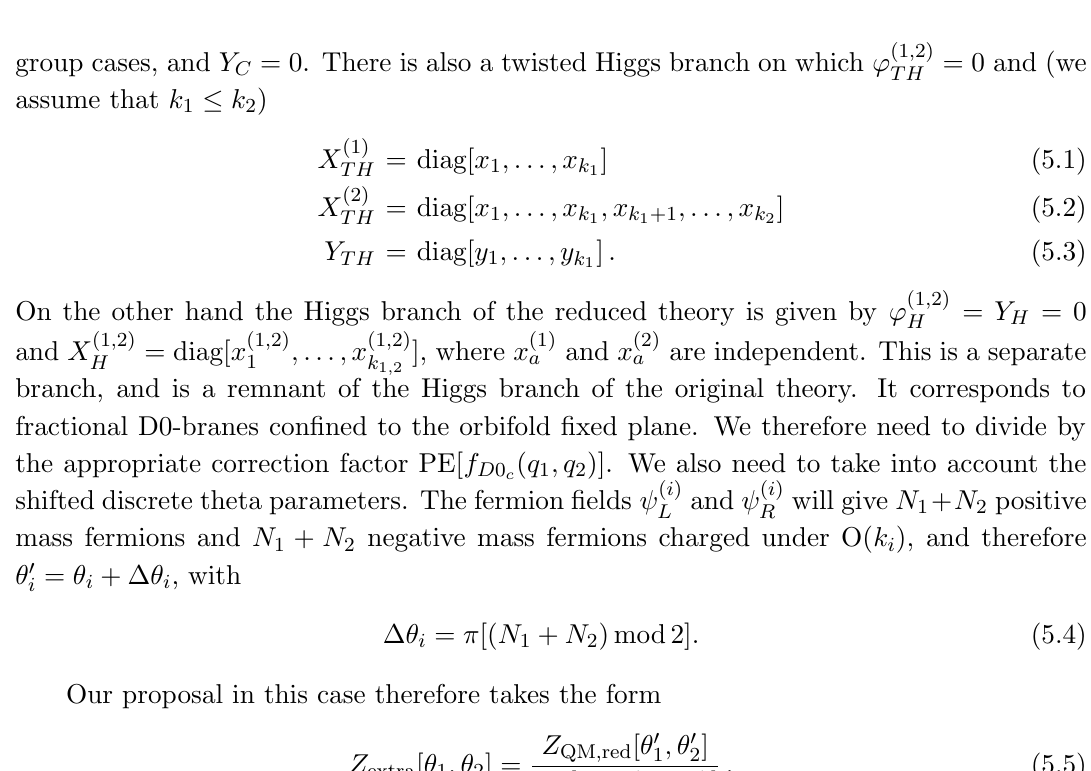
Figure 5 . 1d N = (0 ; 4) theory for the 5d Sp( N The blue and red lines denote symmetric and antisymmetric representations,